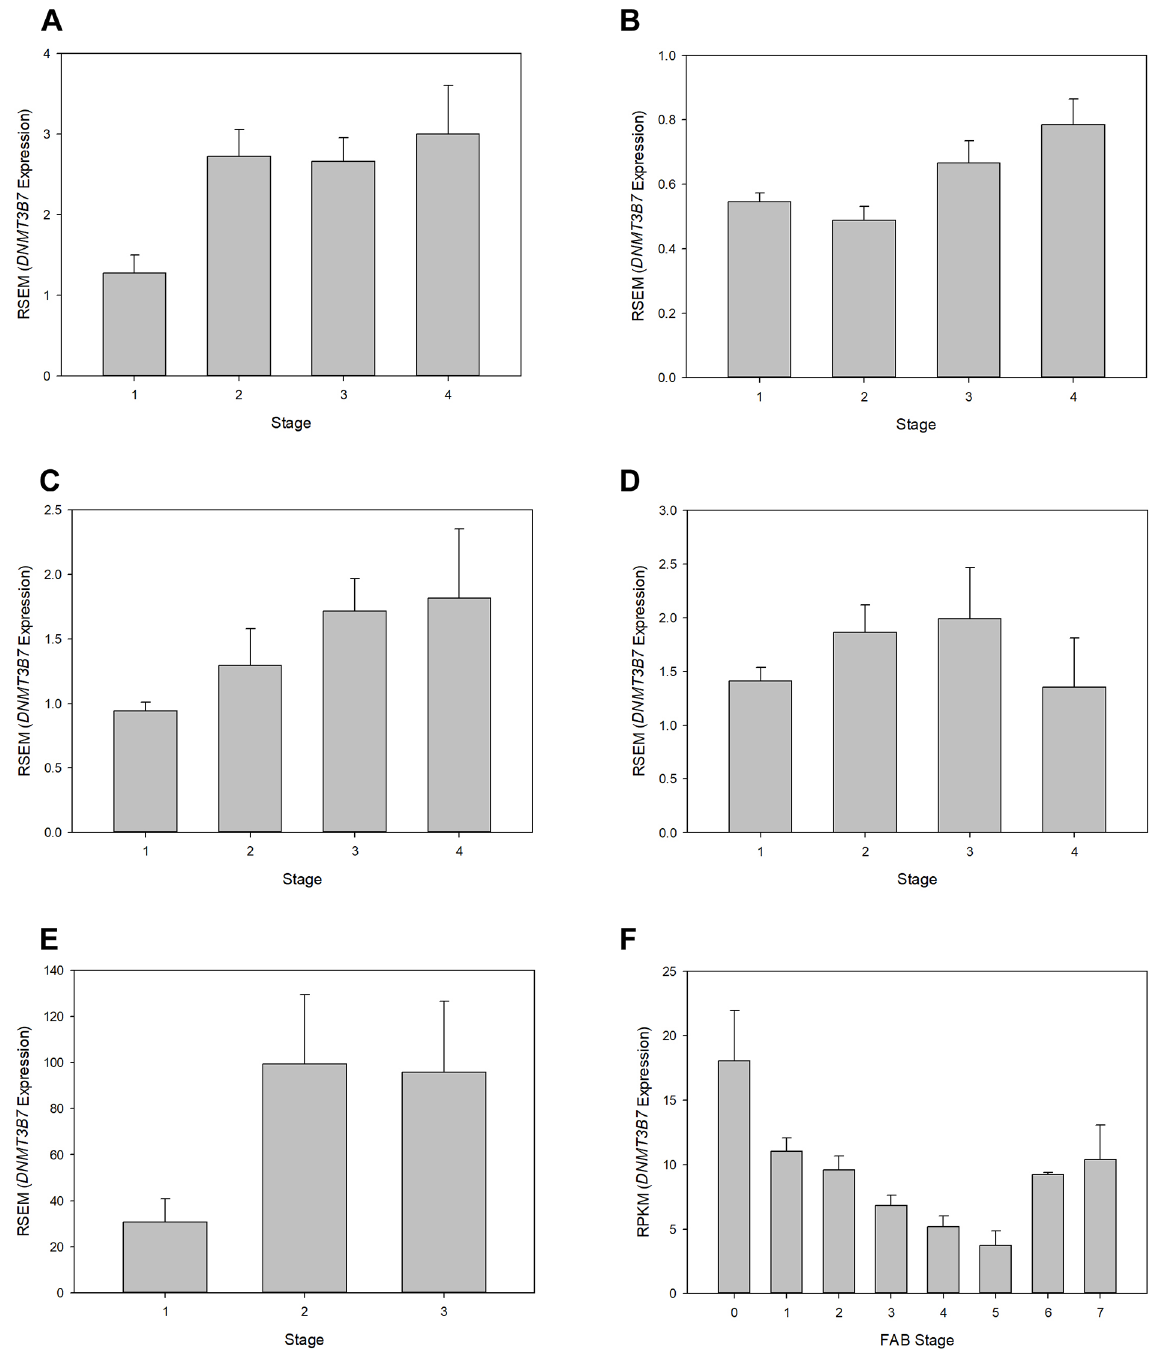
Fig 2. Relative DNMT3B7 expression correlates to clinical staging. DNMT3B7 expression was compared to clinical stage and shown to be significantly different in (A) ESCA, p = 0.012; (B) KIRC, p = 0.010; (C) KIRP, p = 0.02; (D) LUSC, p = 0.003; (E) TGCT, p < 0.001; and (F) LAML, p < 0.001. For (E) TGCT, there were no patient samples with a stage IV diagnosis. (F) LAML staging was measured using the French-American- British (FAB)